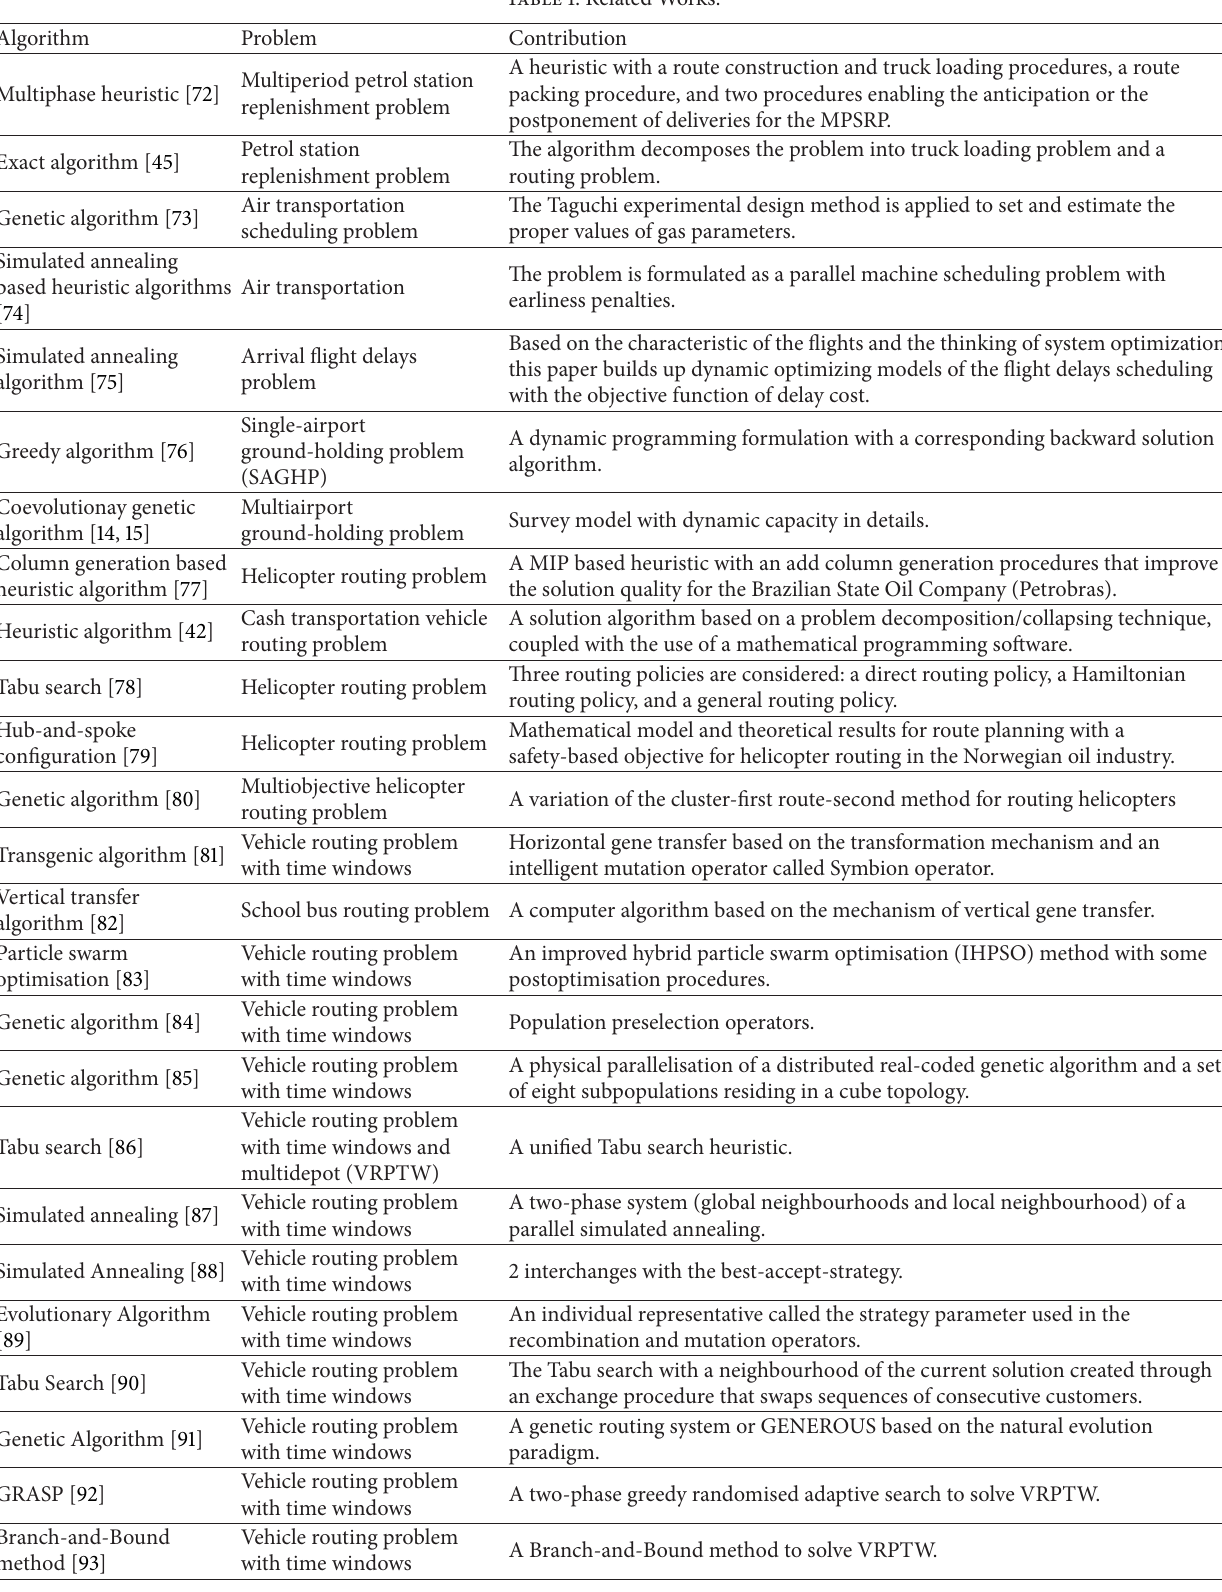
Table 1: Related